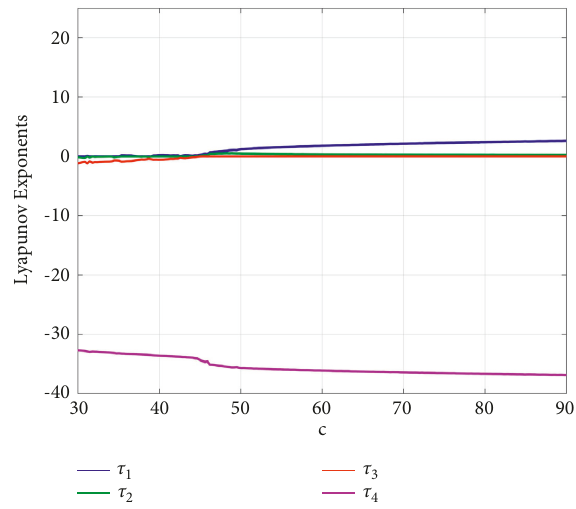
Figure 15: Lyapunov exponents for the model (1) when c varies in [ 30 , 90 ] and ( a,b, d ) � ( 25 , 8 , 6 )